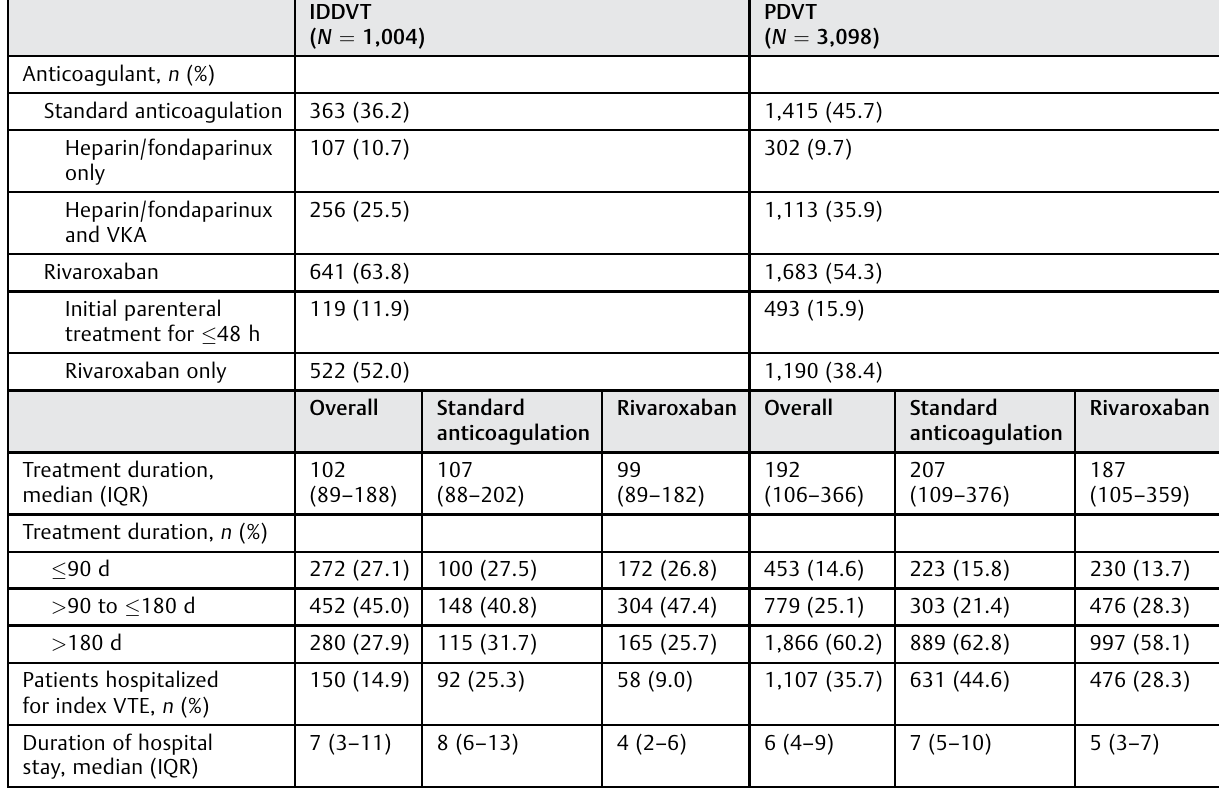
Table 3 Treatment details in patients with IDDVT and PDVT in the safety analysis set IDDVT ( N ¼ 1,004)